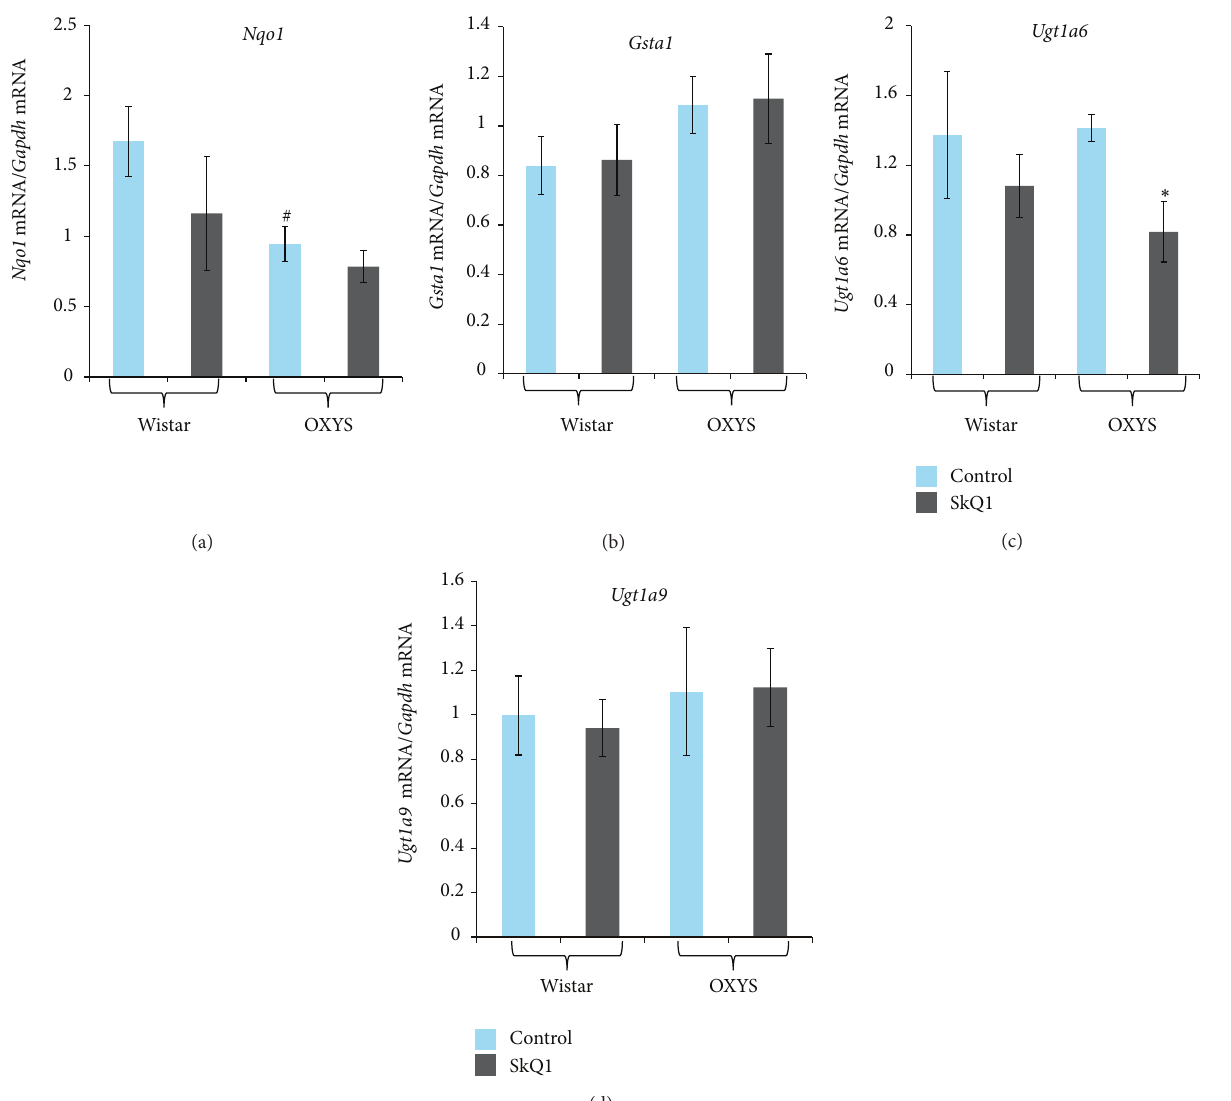
Figure 2: Nrqo1 (a), GstA1 (b), Ugt1a6 (c), and Ugt1a9 (d) mRNA levels in the retinas of 3-month-old Wistar and OXYS rats treated with SkQ1. All data are normalized to the expression level of a housekeeping gene ( Gapdh ). Values are presented as mean ± SEM ( 𝑛 = 6 to 8). Significant differences between groups are marked with ∗ 𝑃 < 0.05